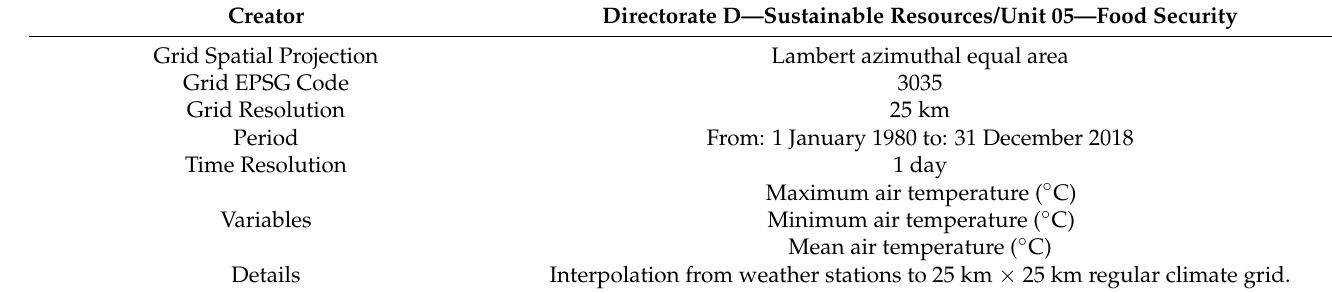
Table 1. Spatial and temporal information about the AGRI4CAST dataset.